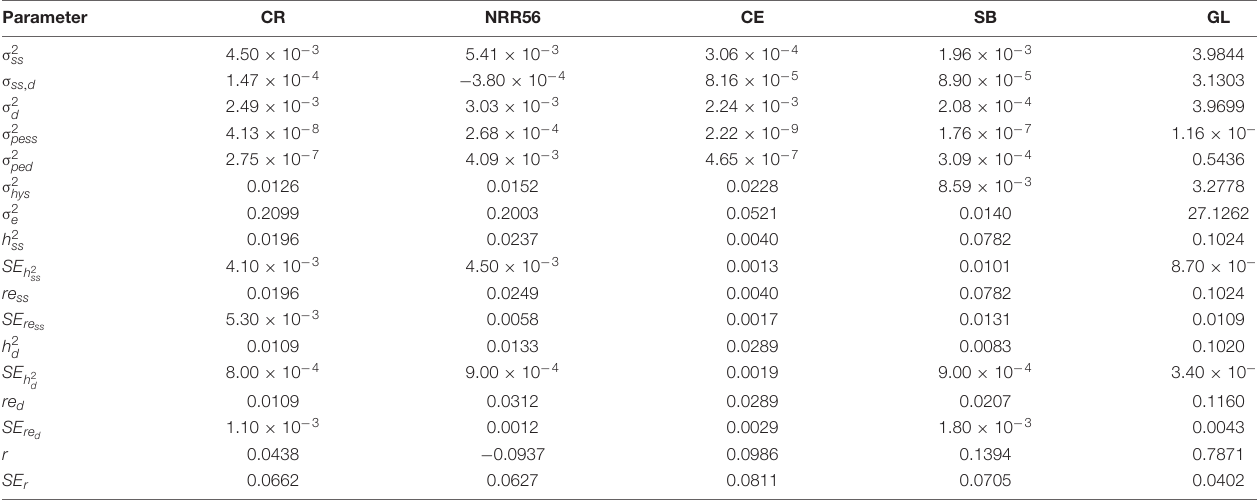
TABLE 2 | Genetic components and parameters for reproductive traits in Holstein cattle. Parameter